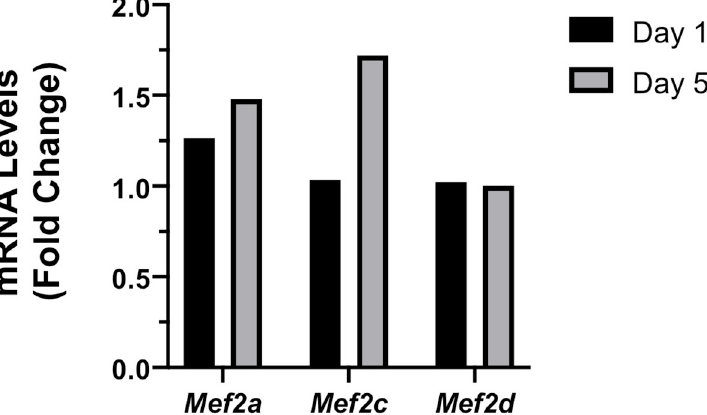
Fig 2. Mef2 gene expression after optic nerve crush. Fold-change gene expression was determined from RNA-seq datasets for control (non-crushed, n = 5), 1 day post-crush ( n = 4) and 5 days post-crush ( n = 4) purified RGCs. At 5 days post-crush, Mef2a and Mef2c mRNA levels were increased 1.5 (FDR = 0.02) and 1.7-fold (FDR = 0.06), respectively, while expression of Mef2d was not changed (FDR = 0.99). Mef2b expression was not detected in RGCs.